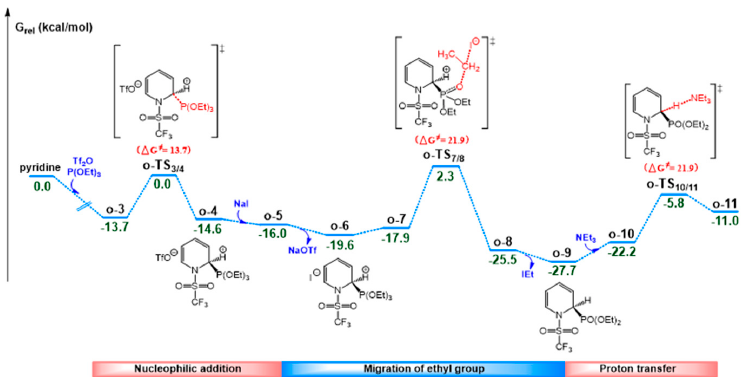
Figure 5. Free energy profile of pyridine phosphination to afford C2 ‐ phosphonates. Table 1. The free energy barriers of key elementary reactions and energies of the C2 ‐ and C4 ‐ phos ‐ phonate products (unit kcal/mol).